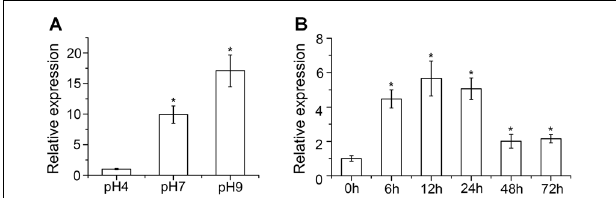
FIGURE 1 | Expression profiles of VmPacC in Valsa mali . (A) Quantitative real-time PCR analysis of VmPacC expression in fungus grown at different pH conditions. RNA samples were isolated from mycelia of the wild-type strain on potato dextrose broth (PDB) medium at pH 4, 7, and 9 after pre-growth on unbuffered PDB for 48 h. (B) Quantitative real-time PCR analysis of VmPacC expression during infection. RNA samples were isolated from apple tree barks around the inoculation site at 0, 6, 12, 24, 48, and 72 h post-inoculation. Transcript abundances (mean and standard deviation) were calculated using data from three independent biological replicates. The asterisk represents a statistically significant difference ( P < 0.05).